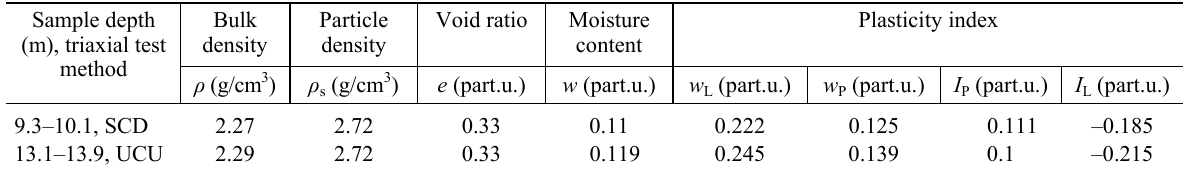
Table 1. Physical properties of the investigated samples